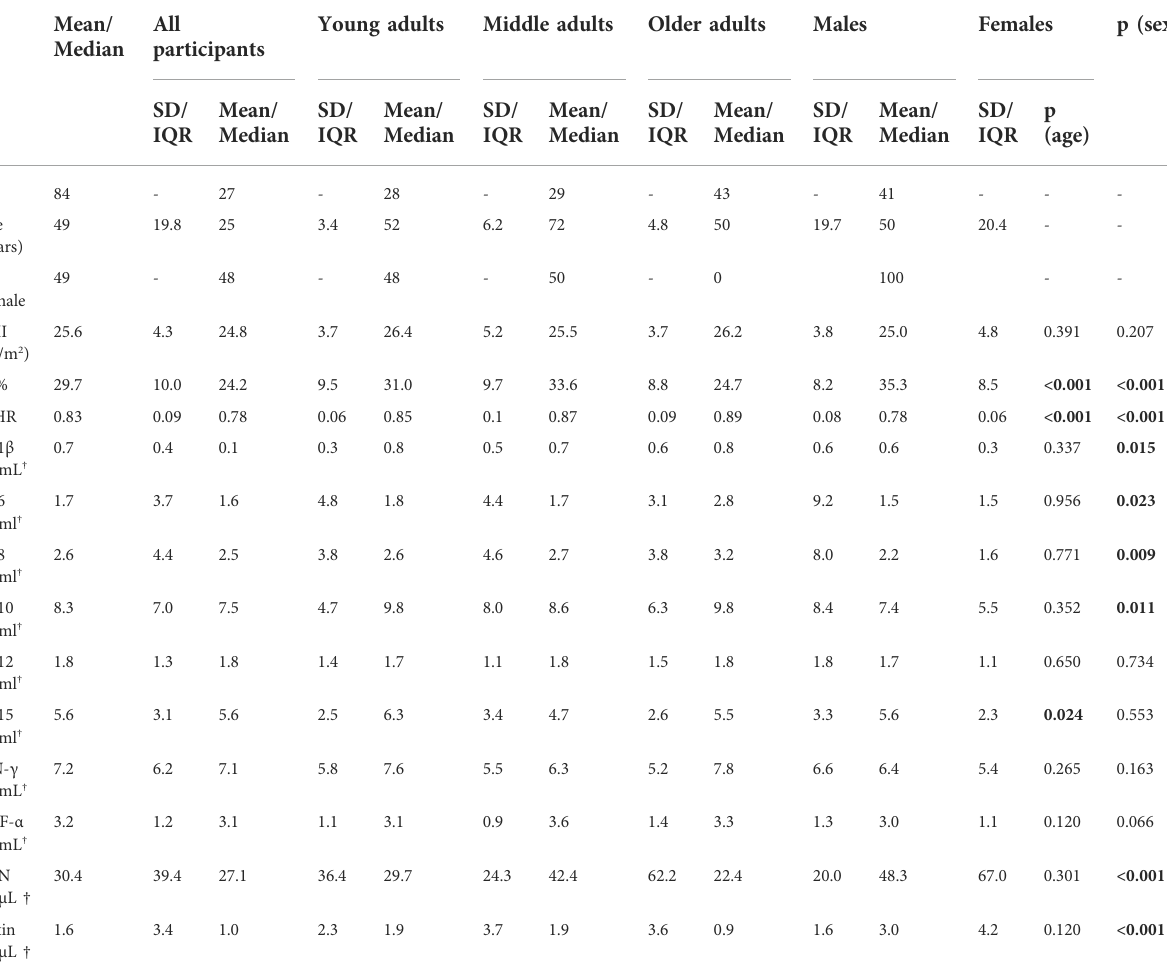
TABLE 1 Participant